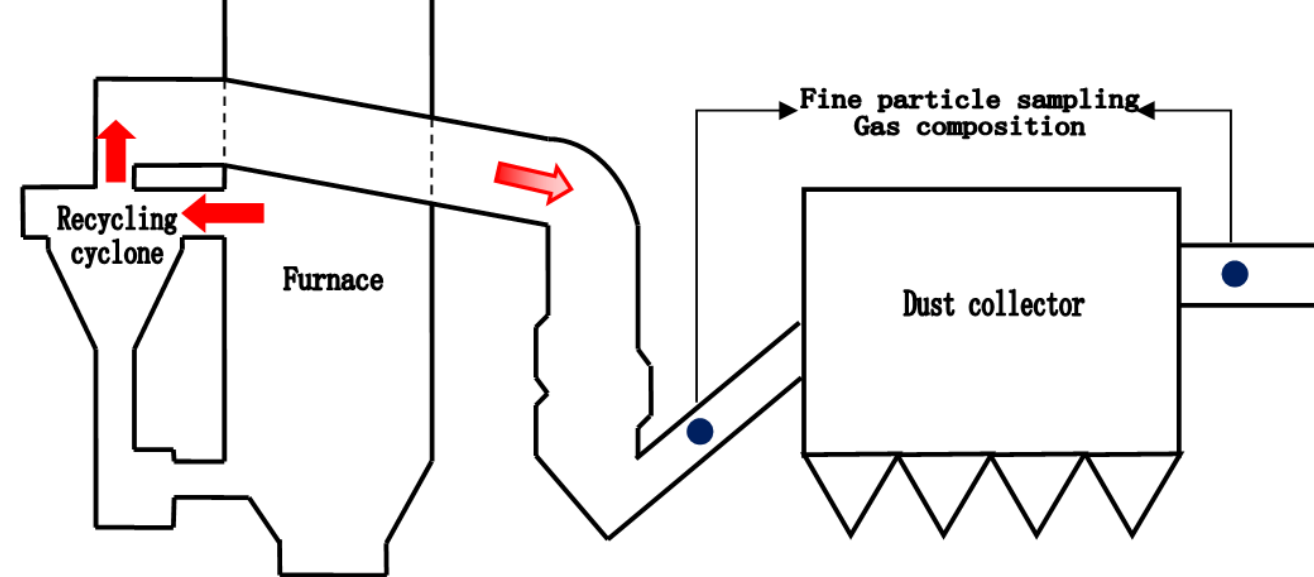
Figure 1. Schematic of CFB boiler and the measuring points arrangement.